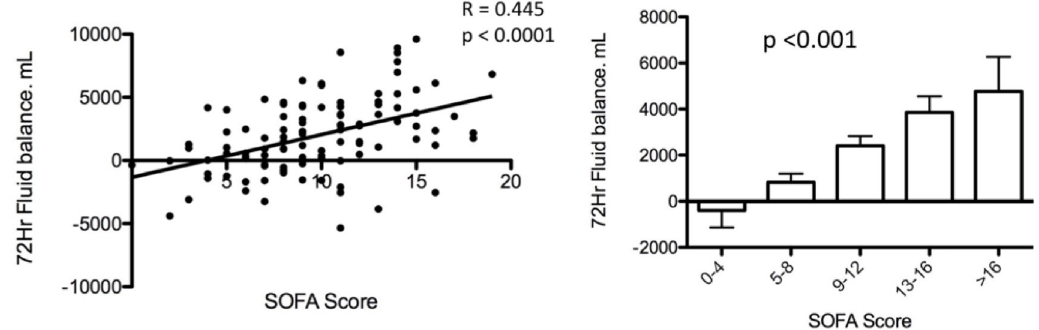
Fig 3. Relationship between 72-hr cumulative fluid balance (CFB) and SOFA score in patients with severe sepsis. (A) Amount of 72-hr CFB correlated well with SOFA score (r = 0.445, p < 0.0001) (data expressed as Pearson correlation); (B) The higher the SOFA score, the more 72-hr CFB was found (p < 0.001 by ANOVA) (data expressed as mean ±